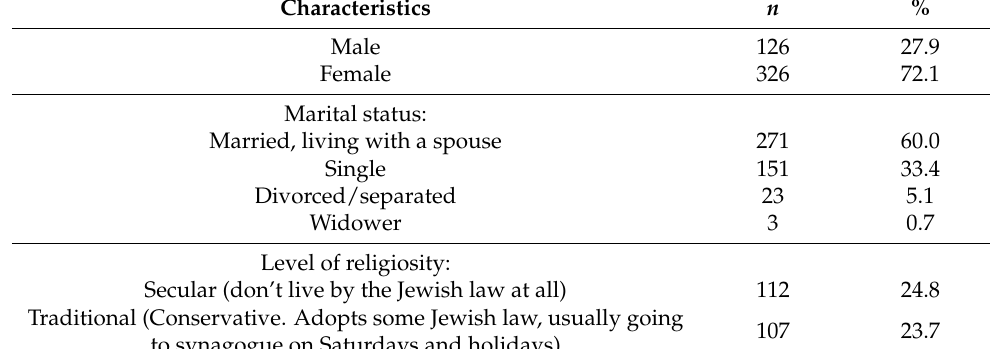
Table 1. Sample characteristics ( n = 452).